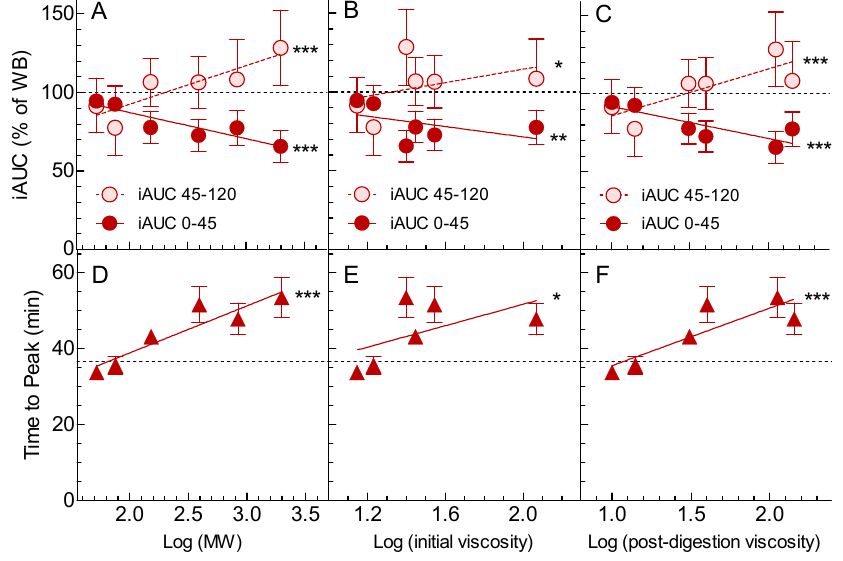
Figure 2. Relationships between glycemic response and β -glucan MW and viscosity. Values are means ± SEM for n = 16 subjects. Panels A, B, and C show incremental areas under the curve (iAUC) expressed as a percentage of that elicited by the Control; dark red circles are iAUC over 0–45 min, light red circles are iAUC over 60–120 min. Panels D, E, and F show the time taken to reach peak glucose in minutes. Panels A and D show the relationships between glycemic responses and log (MW); panels B and E between glycemic responses and log (initial viscosity); and panels C and F between glycemic responses and log (post-digestion viscosity). The black dashed lines show the value for the Control, and dark red solid and light red dashed lines are regression lines. Significance of the regressions by ANOVA: * p < 0.05; ** p < 0.01; *** p < 0.001.